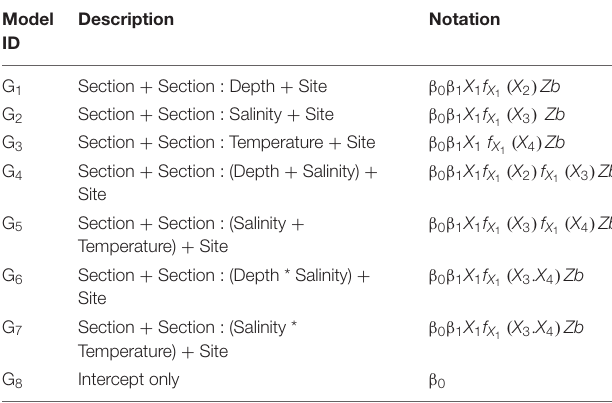
TABLE 1 | Description of the models constructed for the information-criteria-based model